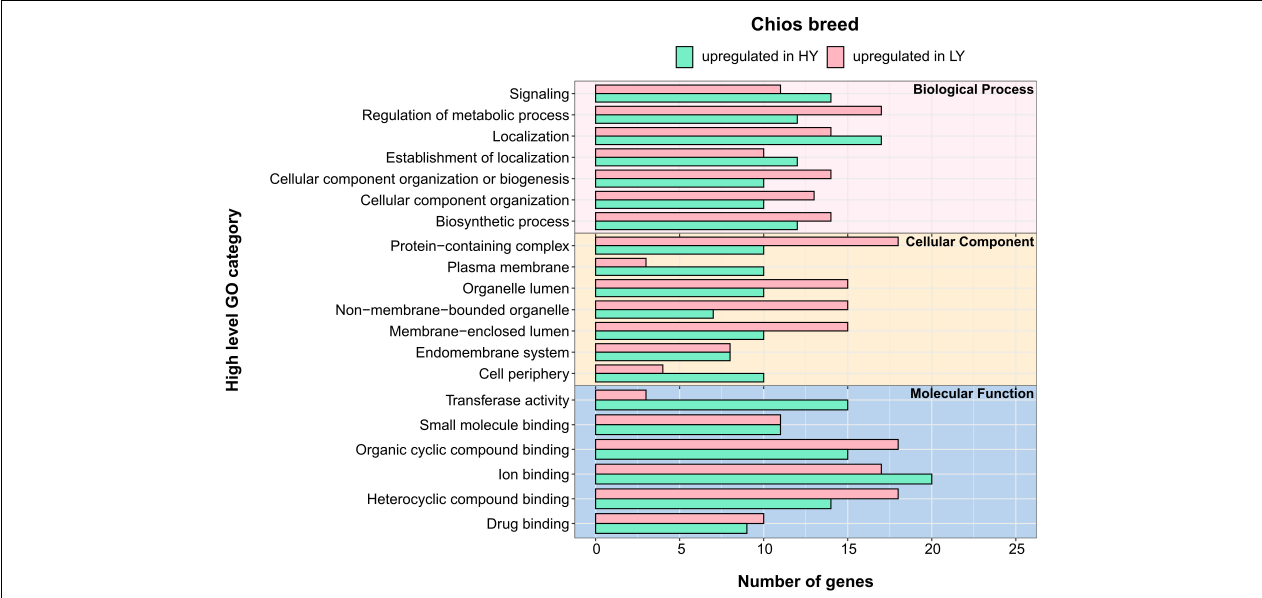
FIGURE 4 | Annotation of differentially expressed genes (DEGs) for the three categories in Chios breed: biological process, cellular component and molecular function. Y -axis illustrates functional categories after annotation of DEGs. X -axis indicates the total number of genes involved in each functional category. Green bars indicate terms that are upregulate in high yielding animals (HY) whereas pink bars indicate the terms that are upregulate in low yielding animals (LY).